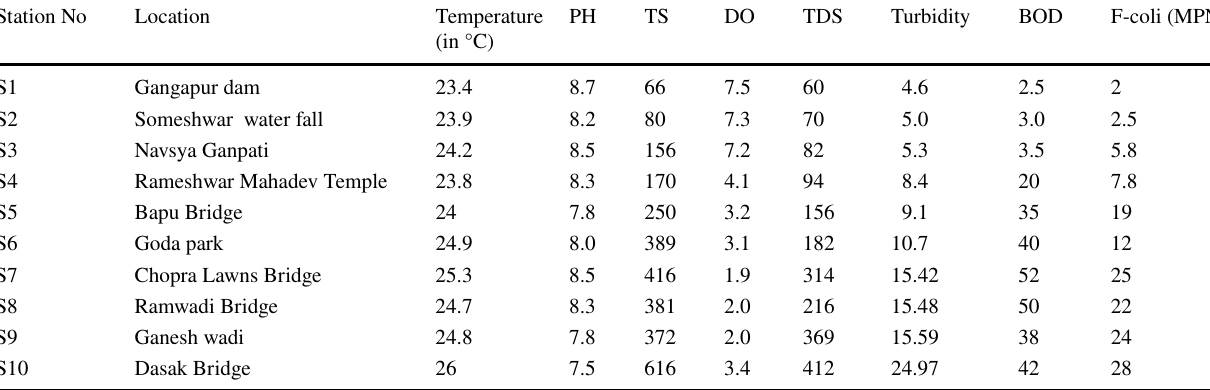
Table 4 The parameters of the Godavari river at Nashik city (June 2019)